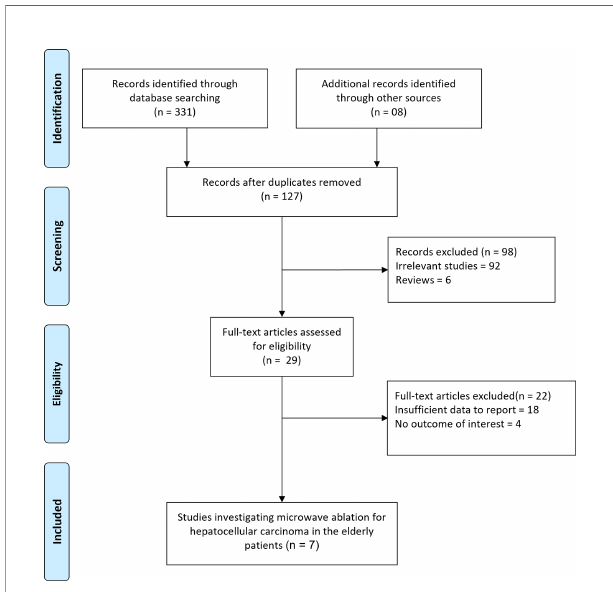
FIGURE 1 | Flow diagram for the selection of studies and speci fi c reasons for exclusion from the present